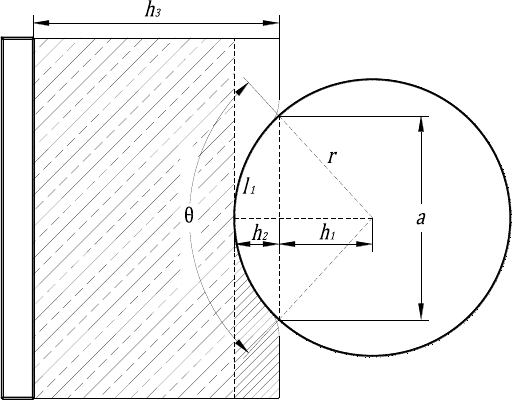
Figure 11. Flexible sponge deformation state.